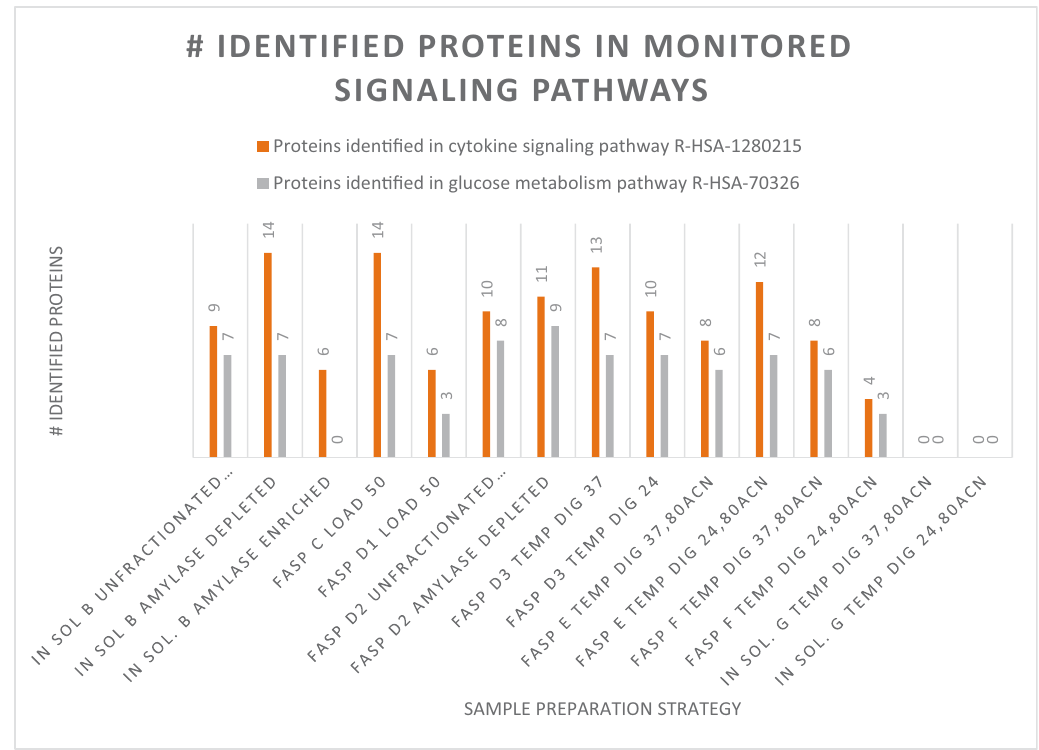
Figure 1: Number of identi fi ed proteins in monitored signaling pathways in correlation with the sample preparation